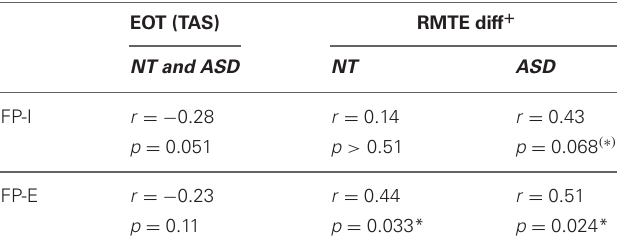
Table 3 | Correlational analyses between Face Puzzle Task and external socio-cognitive